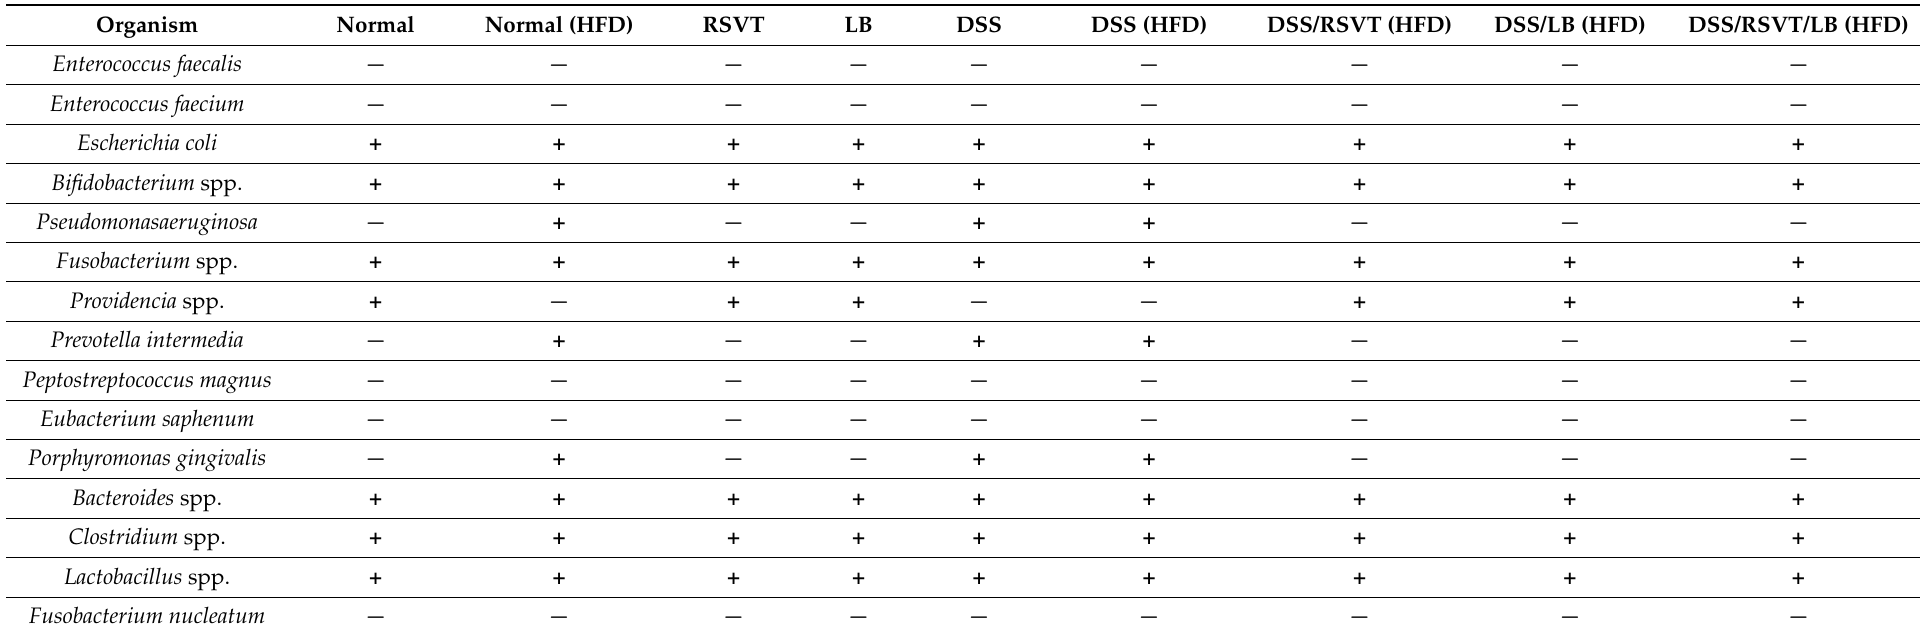
Table 1. Alterations in the gut microbiome composition as detected by conventional